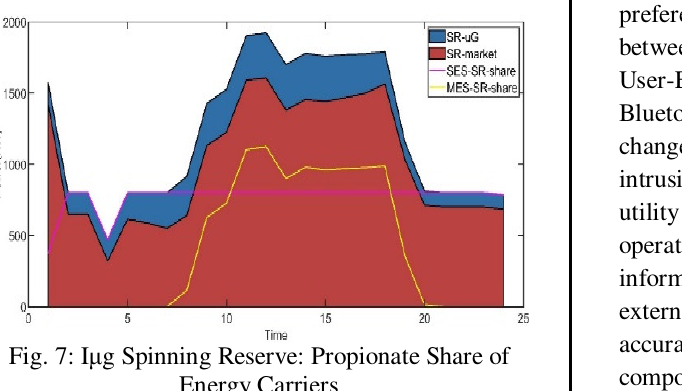
Fig. 6: Industrial Microgrid Load and Transactions with National Grid